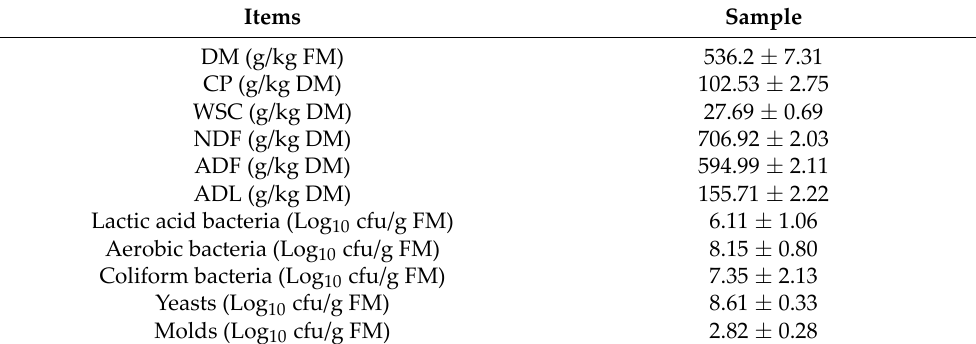
Table 1. Chemical composition and microbial counts of fresh Caragana korshinskii .